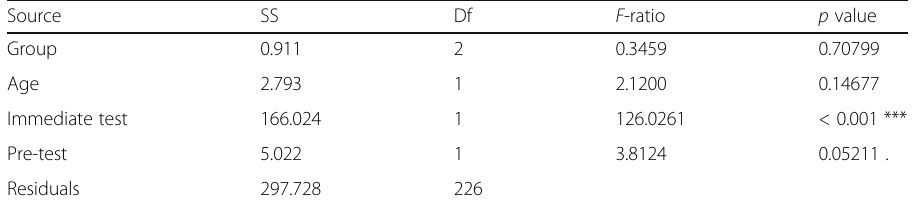
Table 13 Analysis of variance (ANOVA) type II result for immediate test, delayed test and pre-test Source